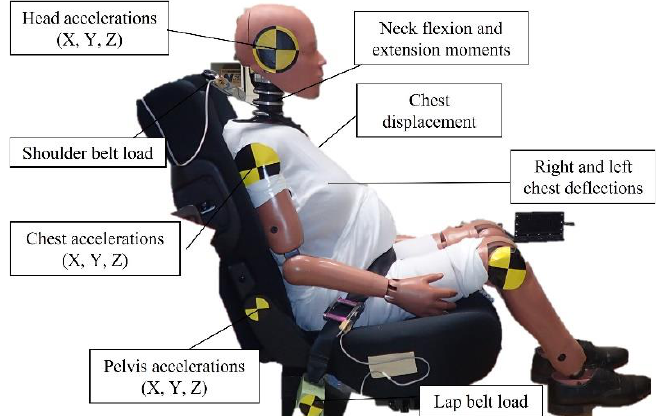
Figure 4. Types and locations of measurements made using the MAMA-2B dummy during sled tests.